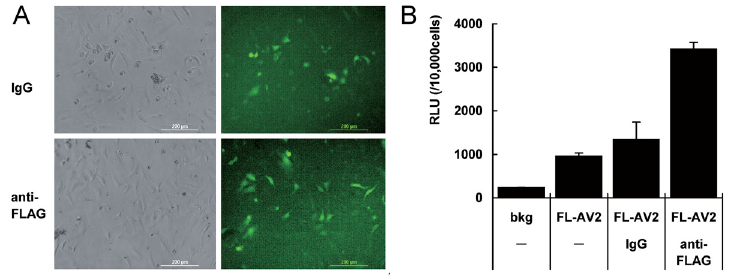
Fig 3. Transduction of immobilized FL-AV2 with a FLAG antibody in 2D HeLa cell cultures. ELISA plates were pre-coated with bovine type I collagen overnight. Anti-FLAG antibody or non-specific IgG mix was cross-linked collagen by incubation with using activated EDAC and SPDP. The plates were loaded with FL-AV2.GFP overnight and washed 3 times with PBS before use. HeLa cells (5×10 4 cells/well in 48-well plates) were seeded into the plates and continuingly cultured for 48 h. Fluorescent images were acquired using a Leica DMIRB microscope. (B) Experiments under same conditions of (A) were performed using FL-AV2.Luc viruses for immobilization and infections. The quantitative chemo-luminescence was determined by luciferase assays. Measurements from 6 independent samples were averaged and presented and shown as